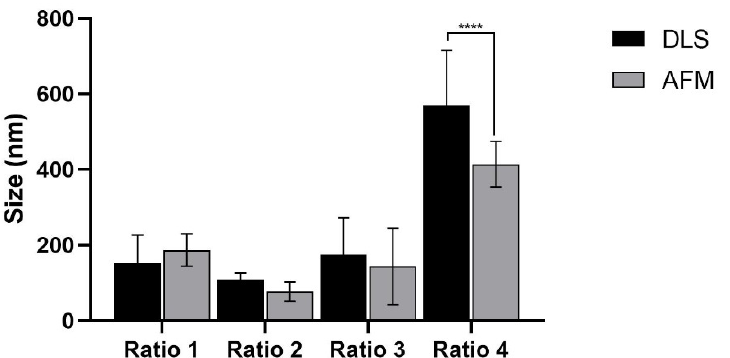
Figure 5. Comparative analysis of the AuNPs mean size determined by DLS (black columns) and AFM (grey columns). Data are represented as mean value ± SD, n ≥ 22. Statistical significance: **** p < 0.0001 comparing to the average hydrodynamic diameter of same type of particles determined by DLS.